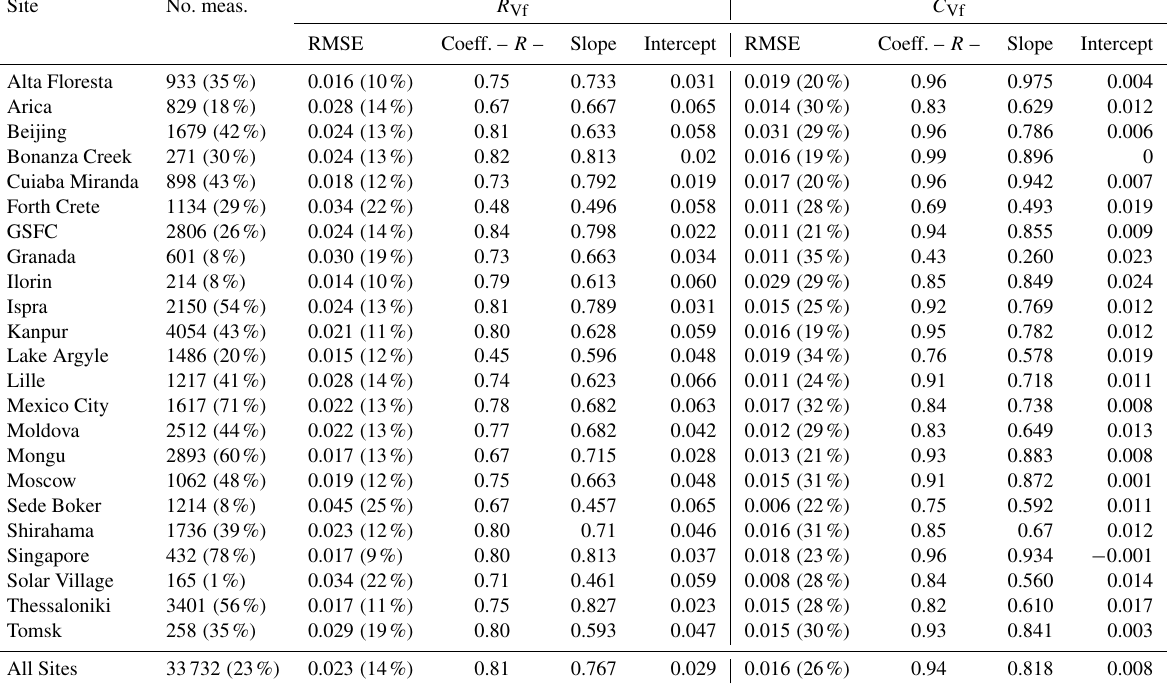
Table 6. Comparison between fine-mode size parameters obtained from the AERONET standard inversion and GRASP-AOD. The first column presents the site and the second column the number of coincident retrievals accomplishing τ( 440 ) > 0 . 2 and α > 1 . 2. The percentage with respect to the total number of coincident retrievals is indicated in parentheses. Columns three to six show the comparison results for volume median radius, while columns 7 to 10 present the results for the fine volume concentration. In both cases, RMSE (and RMSRE enclosed in parentheses) correlation coefficients, slopes and intercepts from linear regressions are